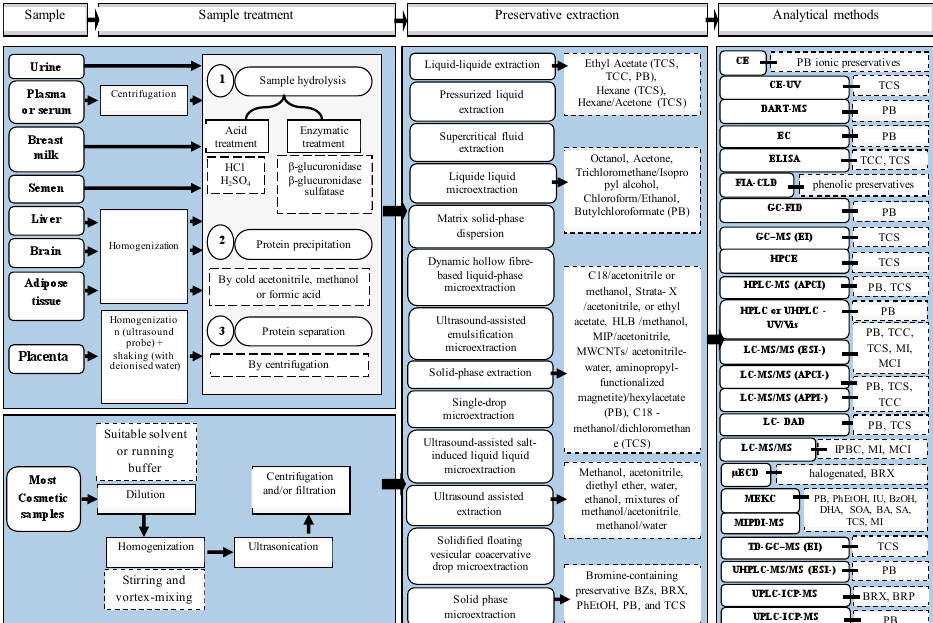
Figure 4. Steps followed in the analysis of cosmetic preservatives from the sample treatment to the analytical methods [137,159,160] where: µECD: microelectron capture detector; APCI: atmospheric pressure chemical ionization; APPI: atmospheric pressure photoionization; BA: benzoic acid; BRP: bronopol; BRX: bronidox; BzOH: benzyl alcohol; BZs: benzoates other than sodium benzoate; CE: capillary electrophoresis; CLD: chemiluminescent detection; DAD: photodiode array detection; DART: direct-analysis-in-real-time; DHA: dehydroacetic acid; EC (D): electrochemical (detector); EI: electron impact; ELISA: enzyme-linked immunosorbent assay; ESI: electrospray ionization; FIA: flow injection analysis; FID: flame-ionization detector; GC: gas chromatography; HLB: divinylbenzene/n-vinylpyrrolidone copolymer; HPCE: high-performance capillary electrophoresis; HPLC: high-performance liquid chromatography; ICP: inductively-coupled plasma; IPBC: iodopropynyl butylcarbamate; IU: imidazolidinyl urea; LC: liquid chromatography; MCI: methylchloroisothiazolinone; MEKC: micellar electrokinetic chromatography; MI: methylisothiazolinone; MIP: molecular imprinted polymer; MIPDI: microwave-induced plasma desorption ionization; MS: mass spectrometry; MWCNTs: multi-walled carbon nanotubes; PB: parabens; PhEtOH: phenoxyethanol; SA: salicylic acid; SOA: sorbic acid; TCC: triclocarban; TCS: triclosan; TD: thermal desorption; UHPLC: ultra-high performance liquid chromatography; UPLC: ultra-performance liquid chromatography; UV: ultraviolet; UV–VIS: